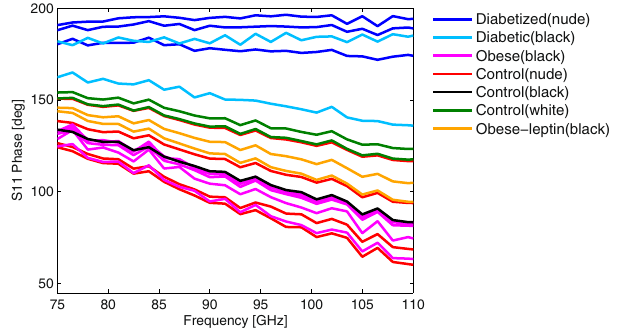
Figure 2. Phase of the reflection coefficient S(1, 1) versus frequency for the different mice